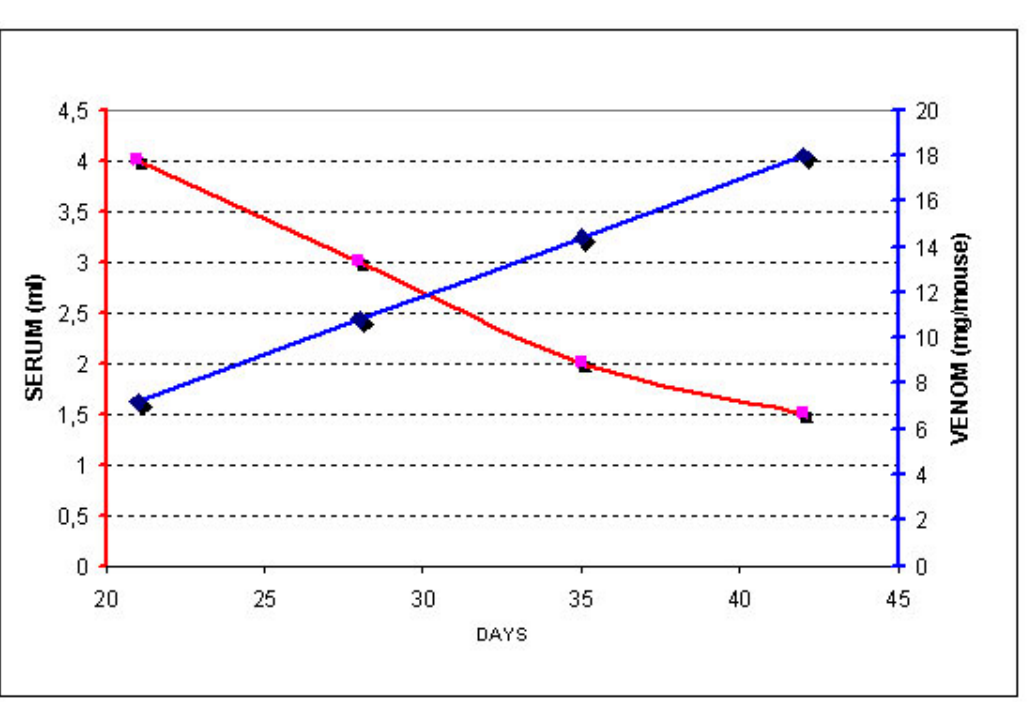
Figure 1: Changes of serum antibody concentration in horses immunized with Androctonus crassicauda venom for production of antivenom. Results are expressed as ED of serum (ml) against 2, 3, 4, 5 LD (mg telson/mouse) in 100 50